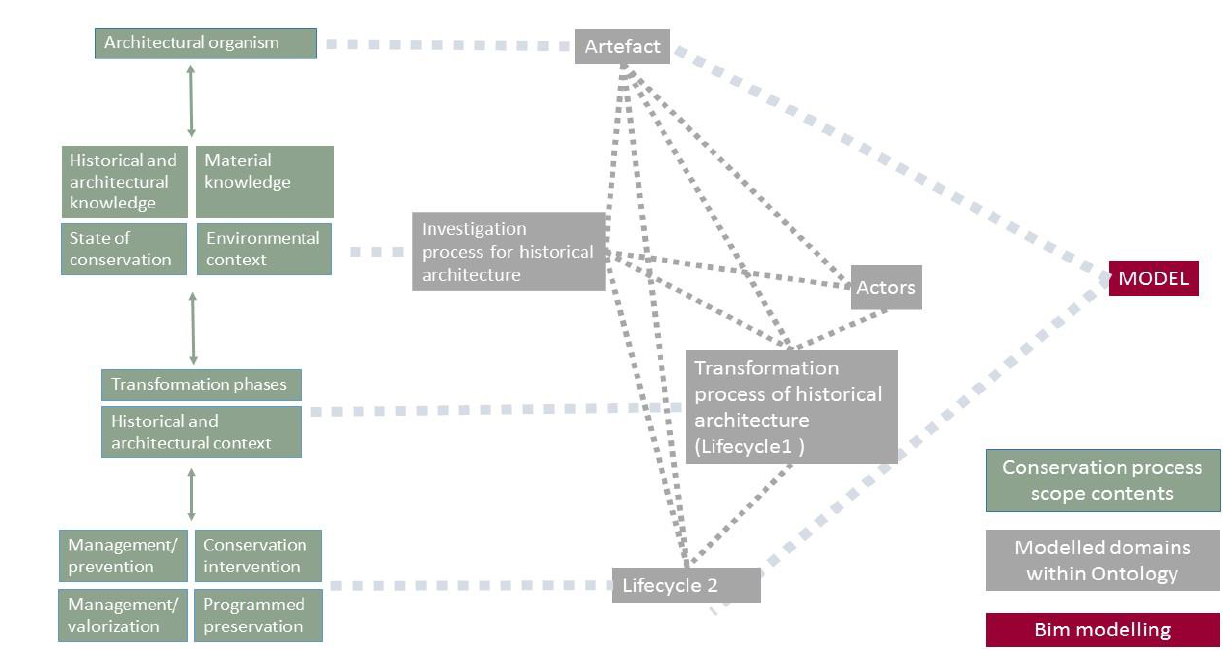
Figure 1. The Conservation process